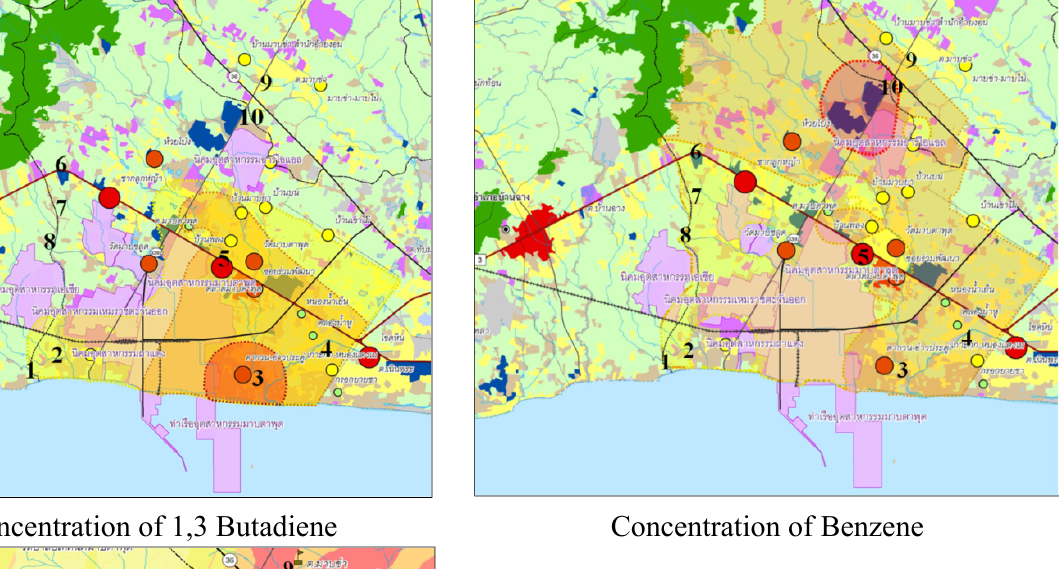
Concentration of 1,3